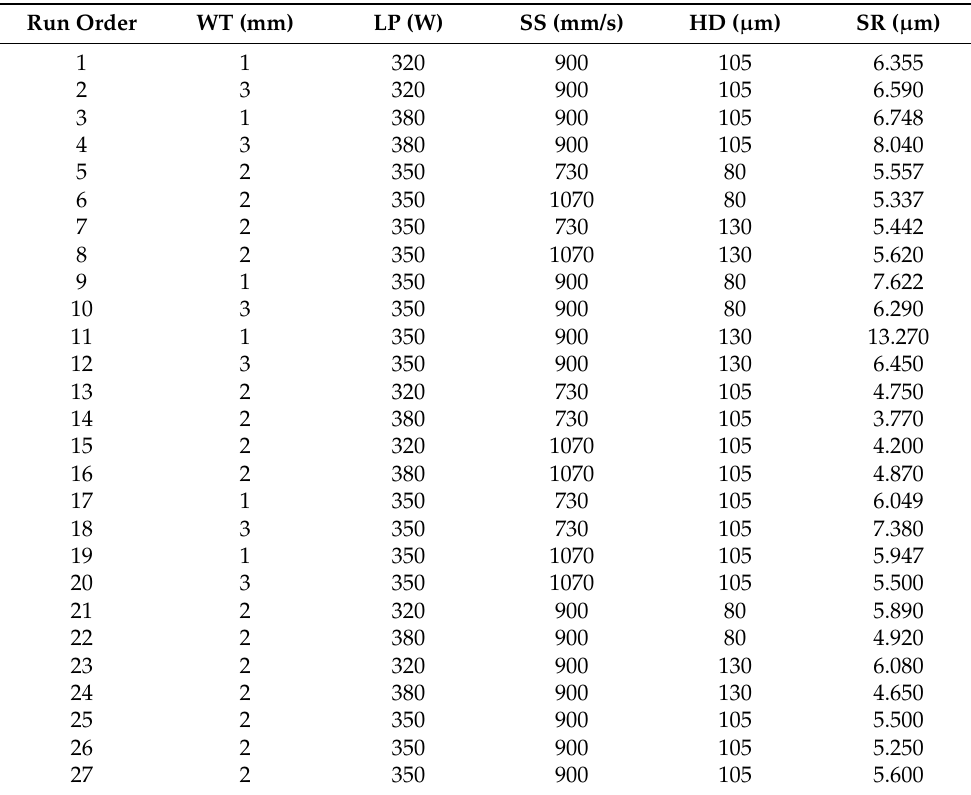
Table 5. Average SR values after sand blasting.